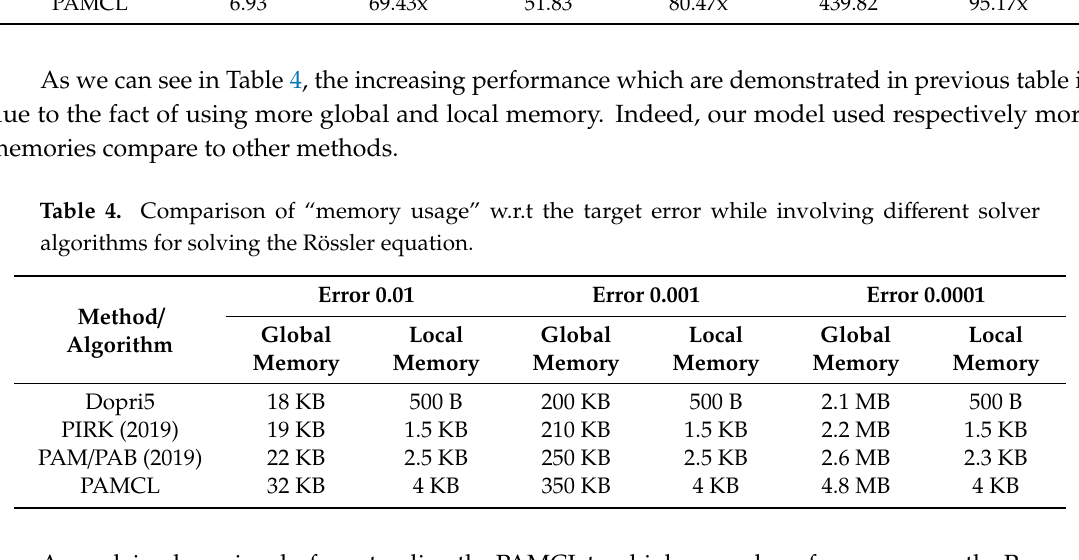
Table 3. Comparison of the “average computation times” on CPU and GPU while using different solver algorithms for solving the Rössler equation.